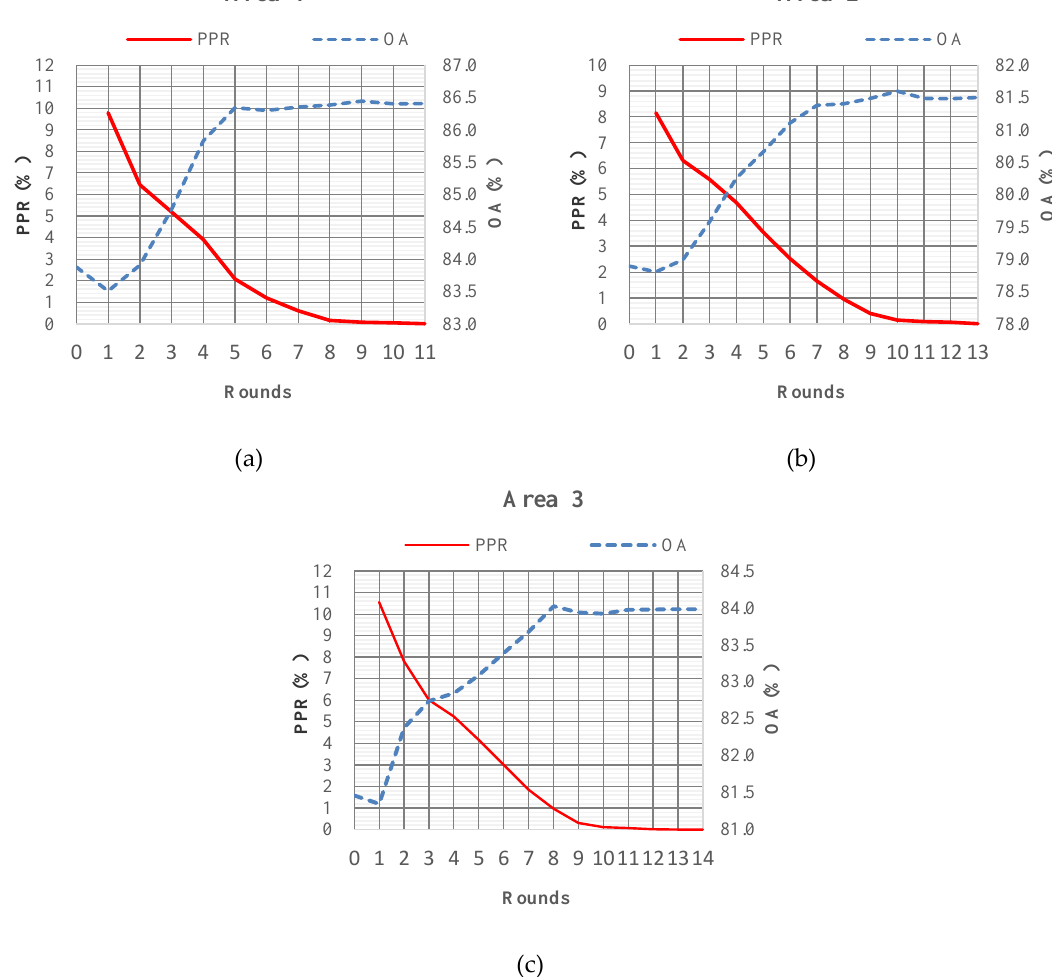
Figure 3. Performance of iterative optimization around the top layer and bottom layer in three Vaihingen sites: ( a ) Area 1, ( b ) Area2 and ( c ) Area 3. PPR ( the percentages of points involved in reclassification) and OA( the overall accuracy)